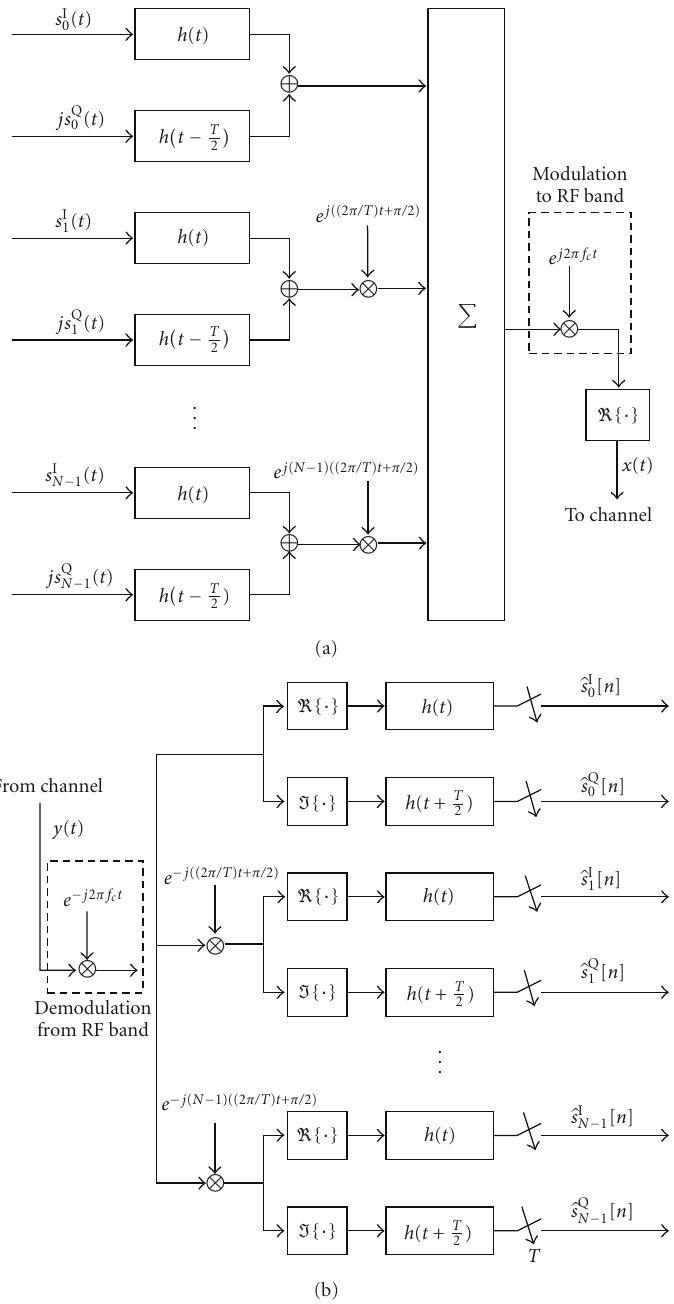
Figure 6: Block diagram of an SMT transceiver: (a) transmitter; (b)